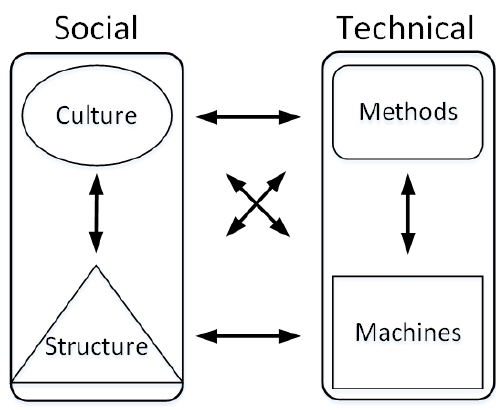
Figure 1. The typical socio-technical